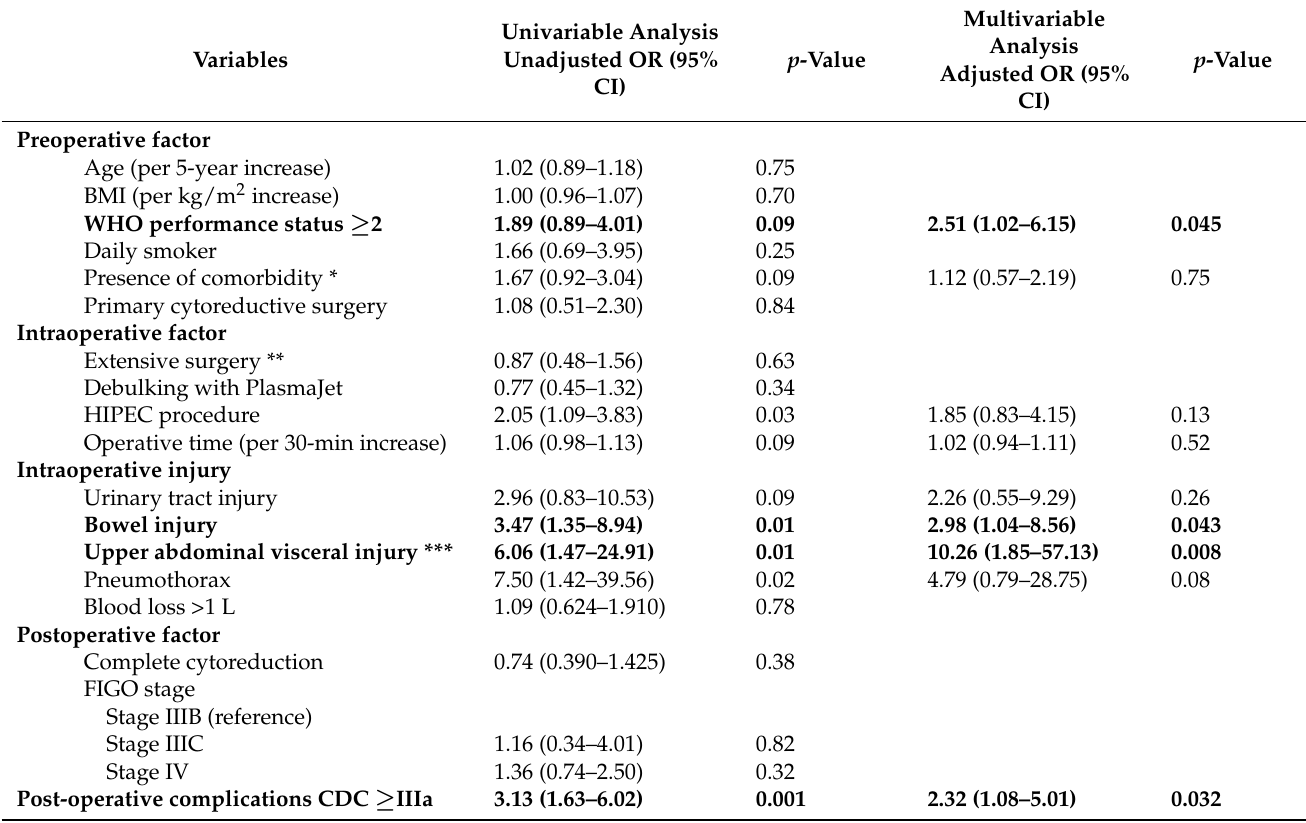
Table 4. Factors related to time to initiating chemotherapy >42